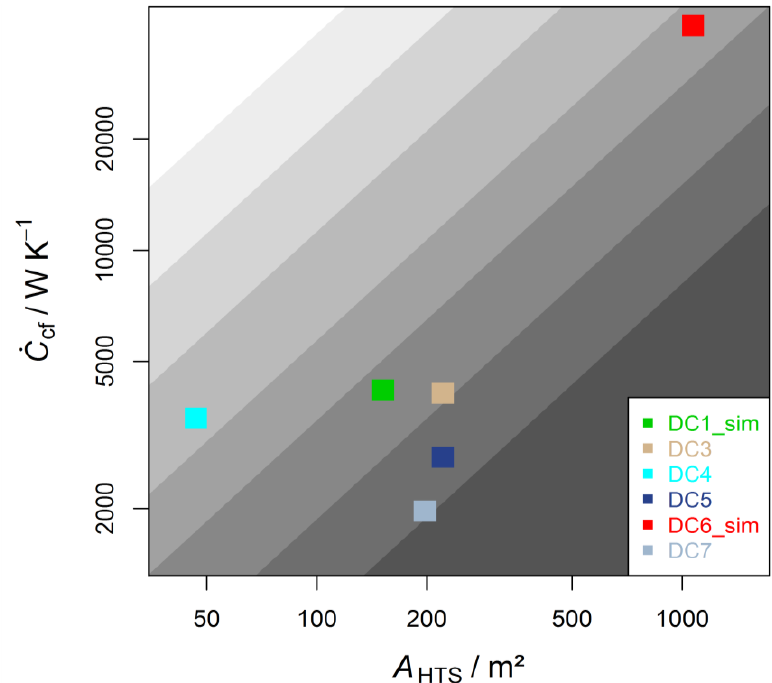
Figure 4. Differences of size and operating conditions of simulated and monitored dry coolers, expressed by heat transfer surface (HTS) and cooling fluid capacity flow rate ( 𝐶̇ Areas of same grey coloration correspond to same ratio of 𝐶̇